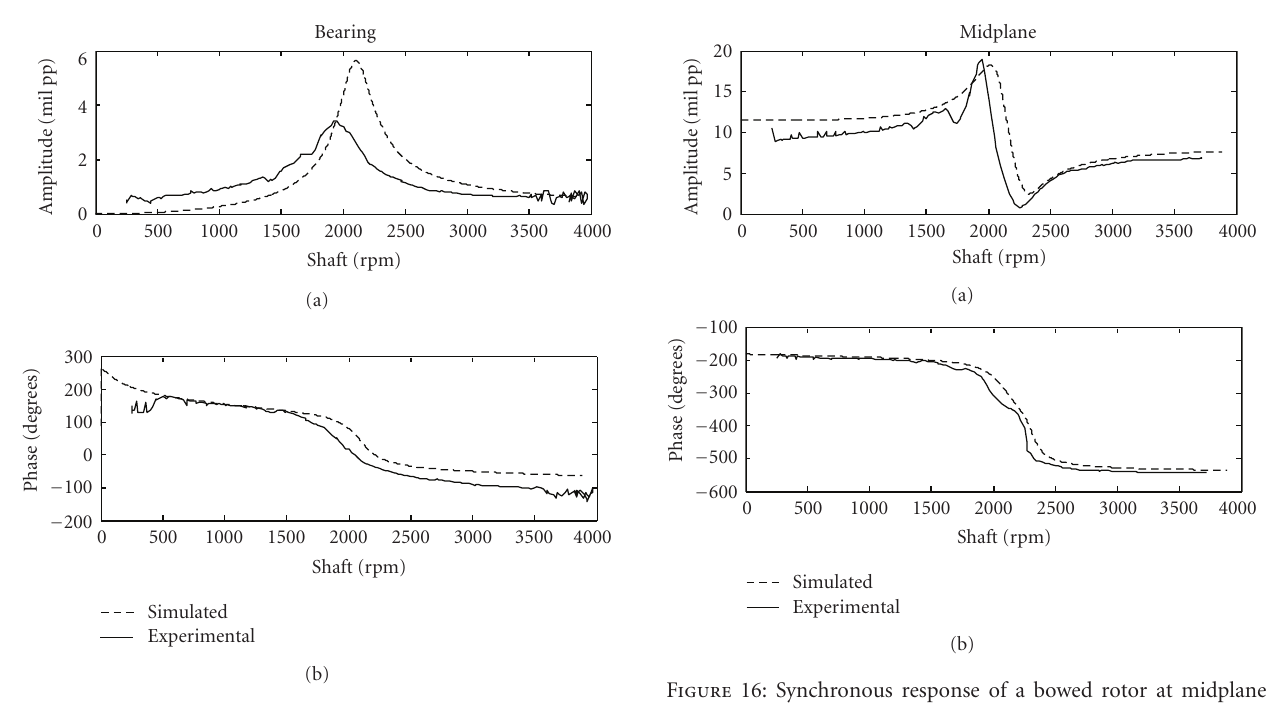
Figure 15: Synchronous response of a bowed rotor at outboard bearing. Ro = .64, ao = 180 ◦ .